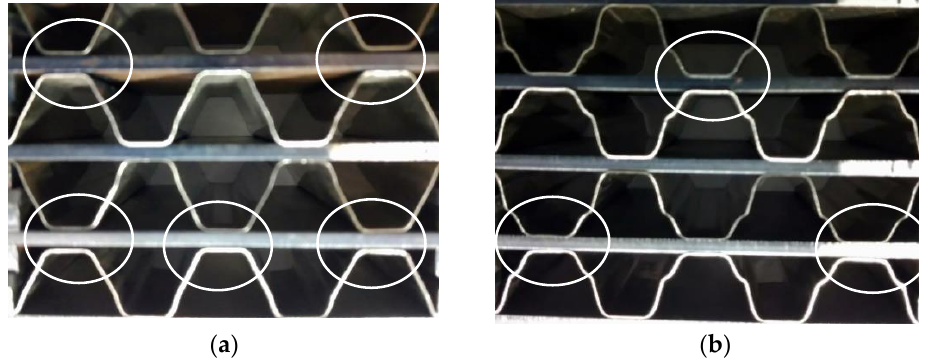
Figure 8. Significant fillet radii of 0.7 mm with compression ratios of ( a ) 30% and ( b ) 46%.